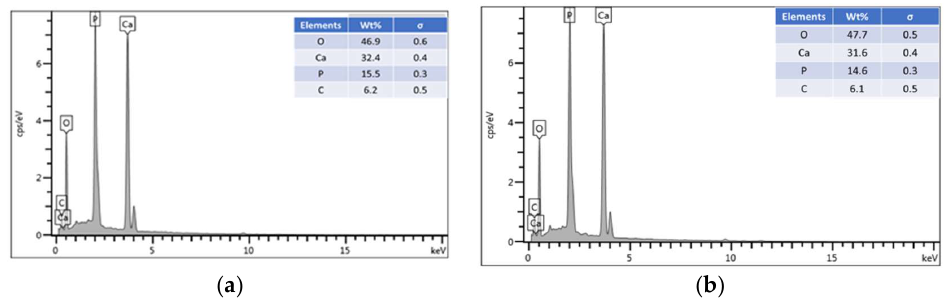
Figure 2. EDX analysis of sinter ( a ) and nonsinter ( b ) hydroxyapatite scaffolds.